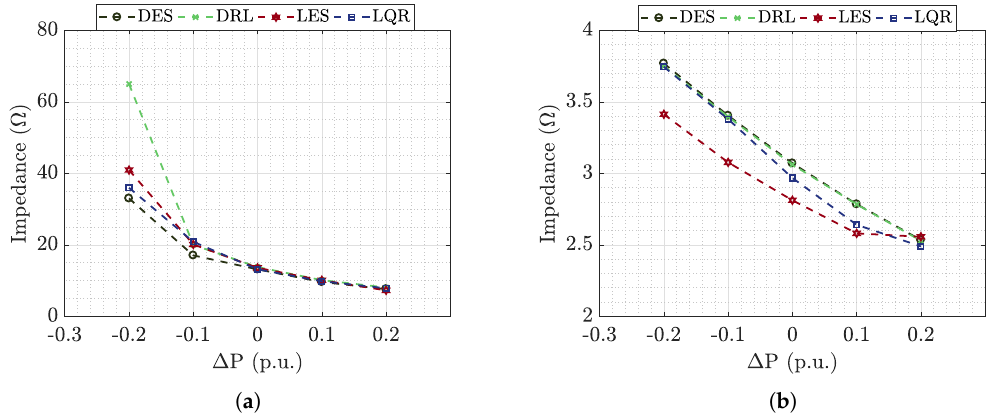
Figure 23. Mean CPL impedance for each power variation during the ( a ) simulation and ( b ) test.